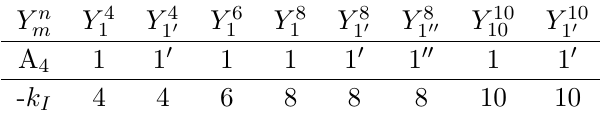
Table 2 . Transformation of Yukawa couplings of higher order under A 4 modular